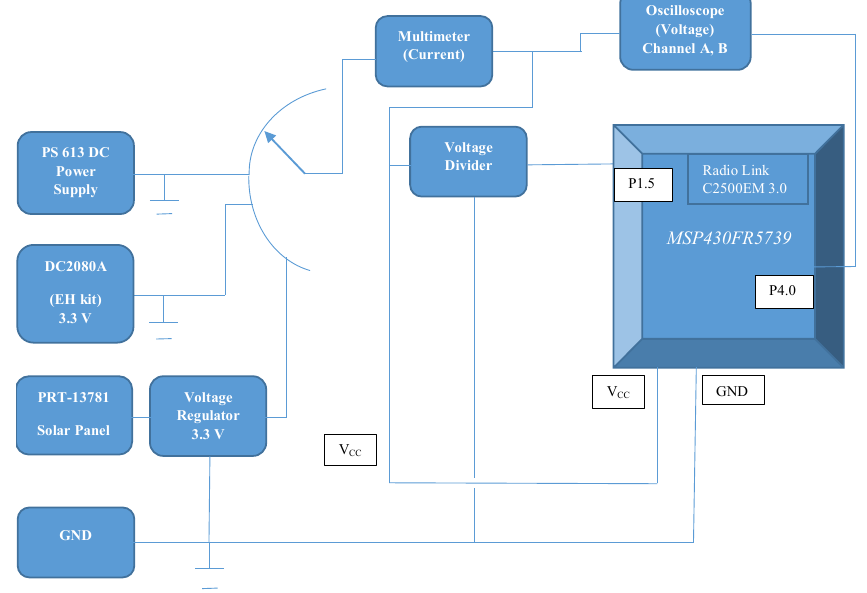
Figure 4. Block diagram of the experimental setup used to test TC with the FRAM-based microcontroller and radio link. It is possible to switch between a regulated DC power supply, energy harvesting kit (with onboard solar and TEG sources and external RF source), and the external solar panel. When the reference voltage on P1.5 lowers down to the value set in software, the ctpl_enterShutdown () software function is triggered; this can be verified on P4.0.